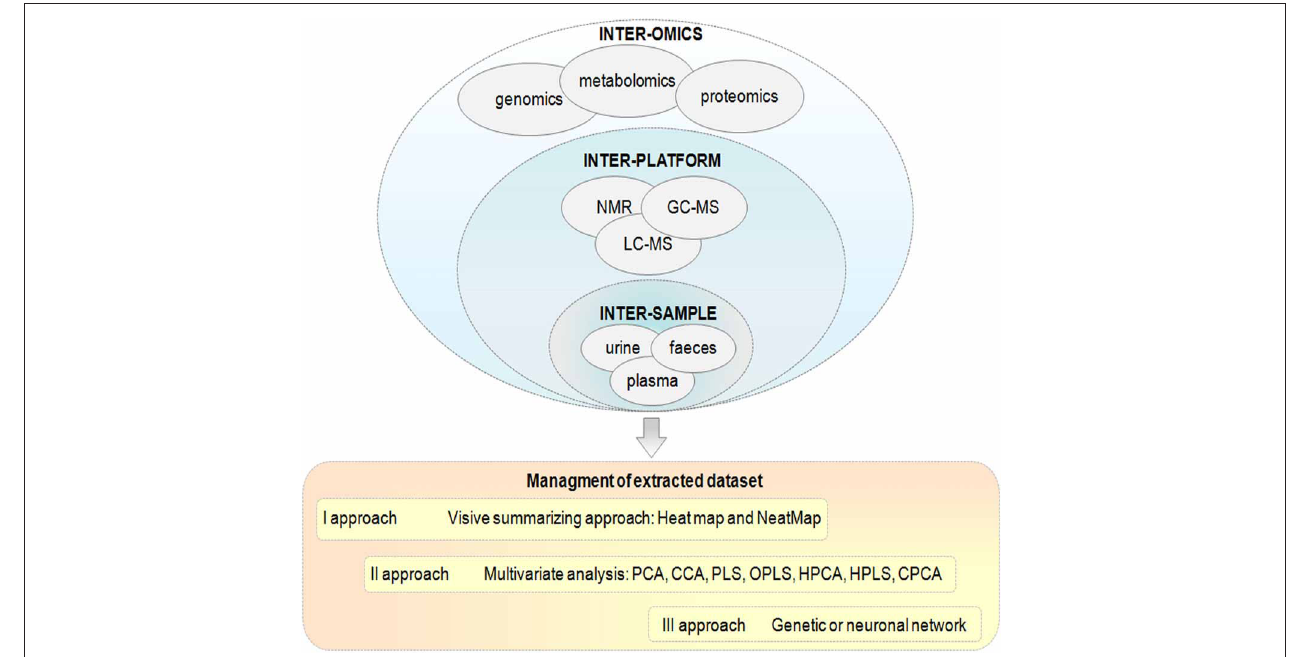
FIGURE 3 | Schematic representation of statistical data integration methods in the area of inter-omic, inter-platform, and inter-sample integration. The management of different dataset derived from the metabolomic approaches are integrated by the most diffuse multivariate methods.